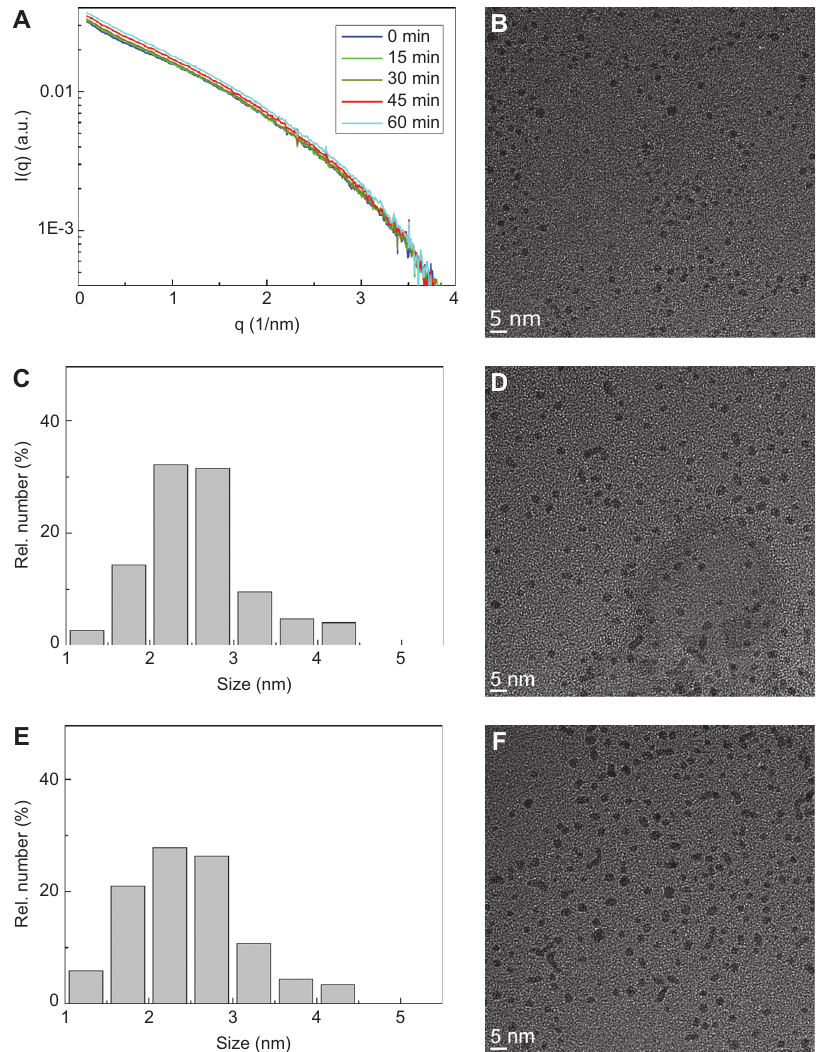
Figure 11 (A) Semi-online SAXS curves of the Pd NP during the reaction at room temperature. TEM images of the utilized Pd NPs (B) before, (D) after the oxidation reaction of benzyl alcohol, and (F) after the first reactivation. All scale bars are 5 nm. Size distribution of the Pd NPs (C) after the reaction and (E) after the first